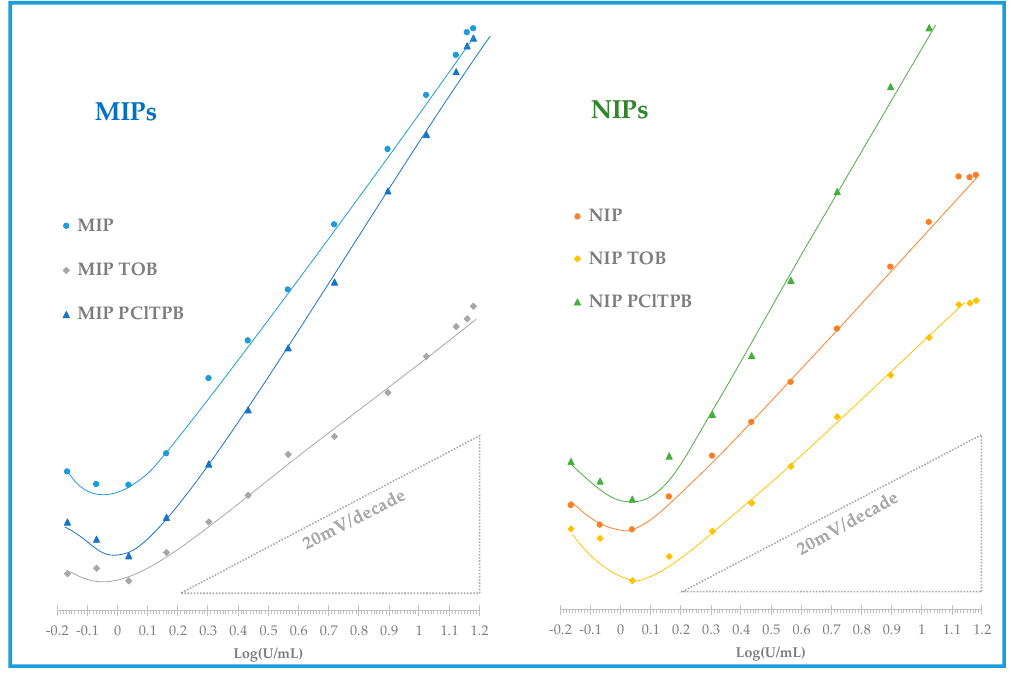
Figure 5. Potentiometric response of CA15-3 PVC membrane sensors with CA 15-3 standard solutions prepared in HEPES buffer, in pH 6.5.